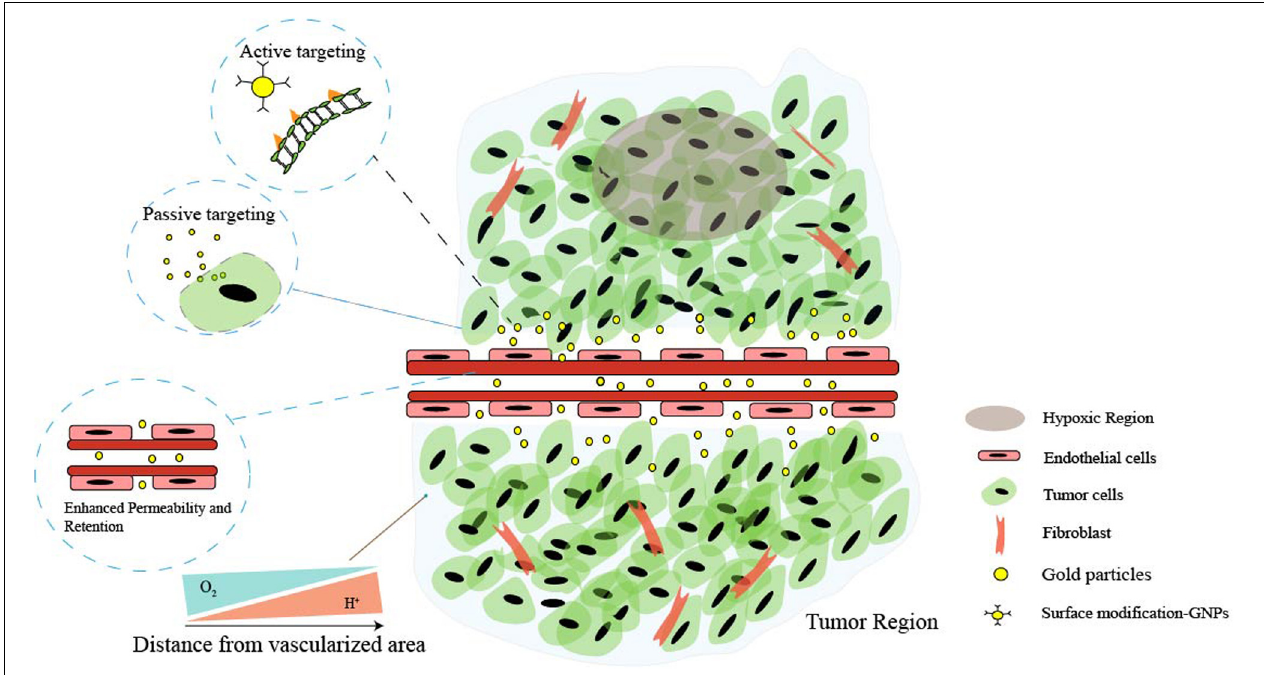
FIGURE 1 | Schematic illustration of the main features of tumor microenvironment (TME). Cancer cells and non-malignant cells coexist in the extracellular matrix (ECM). Characteristics of the tumor microenvironment include acidity, hypoxia, hypertonicity, and recruitment of stromal and immune cells. Low perfusion of abnormal vessels typically limits both O 2 delivery and removal of acidic waste products by oxidative metabolism and Warburg effect. Moreover, the gaps in the endothelial lining of cancer vessels are excessive (ranging from one to hundreds of nanometers), and nanoparticles can simply extravasate through these gaps, which is the enhanced permeability and retention (EPR) characteristic of TME. Additionally, the EPR effect enables nanoparticles to passively and preferentially accumulate and penetrate into the tumor, and through the surface affinity ligand modification, nanoparticles can actively target the specific receptors of cancer cells.